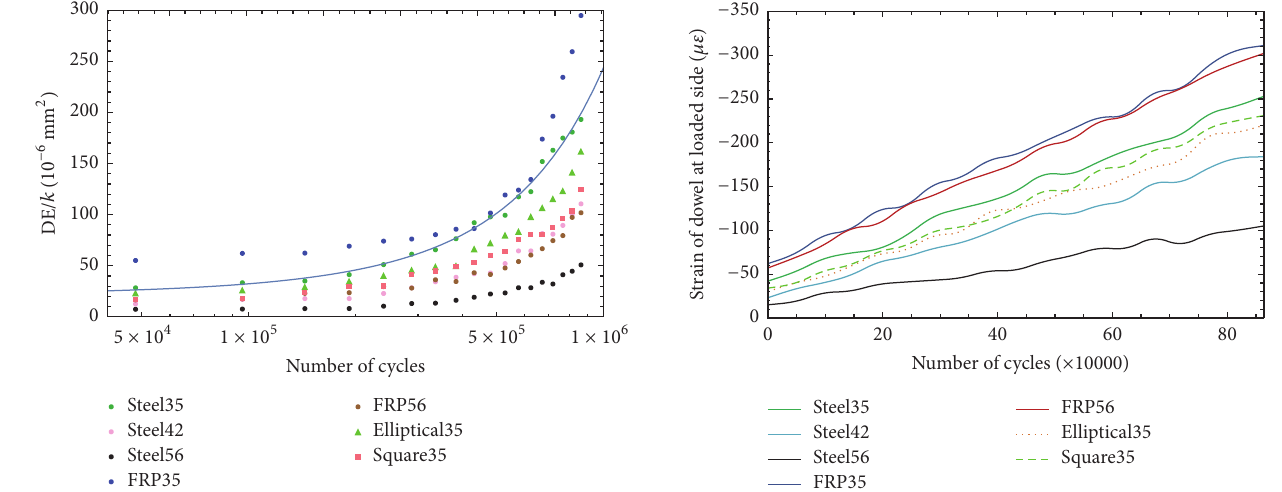
Figure 11: The ratio of differential energy to modulus of subgrade reaction.